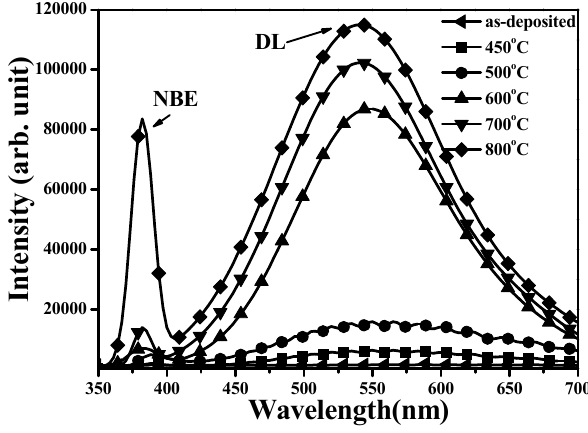
Figure 1. Room temperature photoluminescence (RTPL) spectra of as-deposited n -ZnO film and the films annealed at 450, 500, 600, 700, and 800 ˝ C, respectively, under vacuum atmosphere for 30